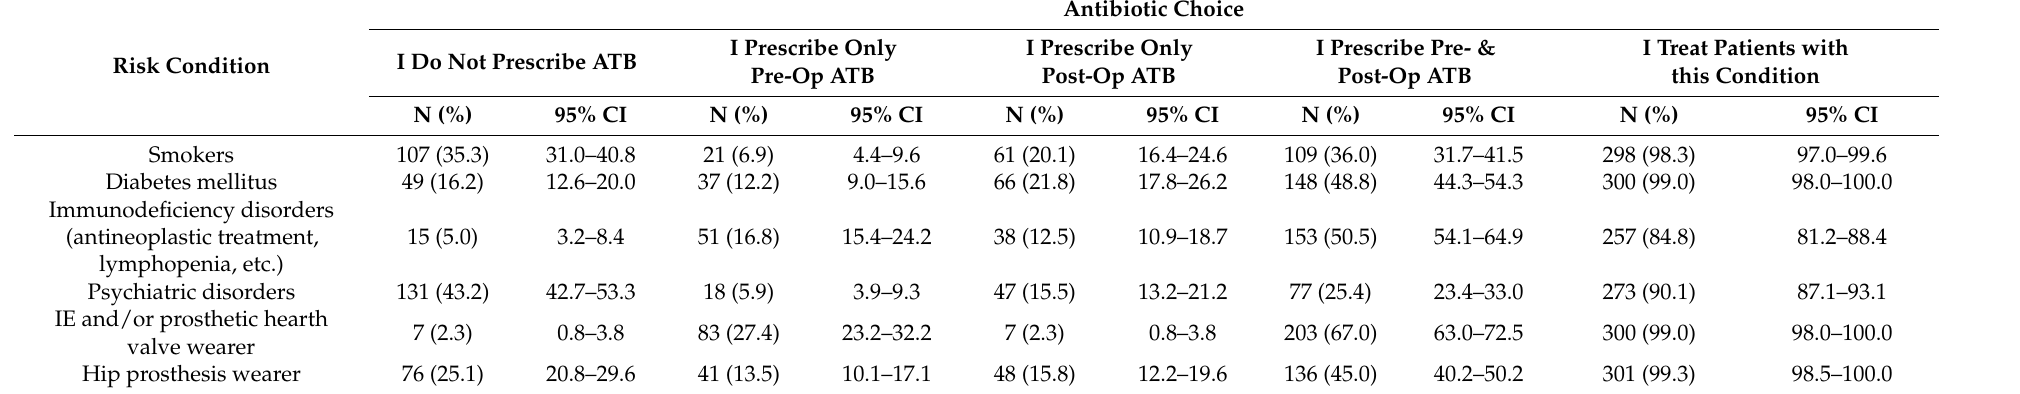
Table 3. Antibiotic prescription choices in patients with risk